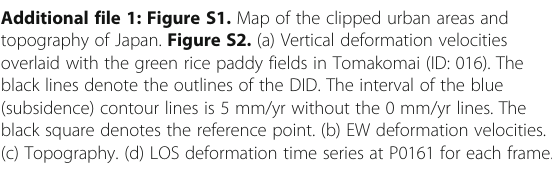
Additional file 1: Figure S1. Map of the clipped urban areas and topography of Japan. Figure S2. (a) Vertical deformation velocities overlaid with the green rice paddy fields in Tomakomai (ID: 016). The black lines denote the outlines of the DID. The interval of the blue (subsidence) contour lines is 5 mm/yr without the 0 mm/yr lines. The black square denotes the reference point. (b) EW deformation velocities. (c) Topography. (d) LOS deformation time series at P0161 for each